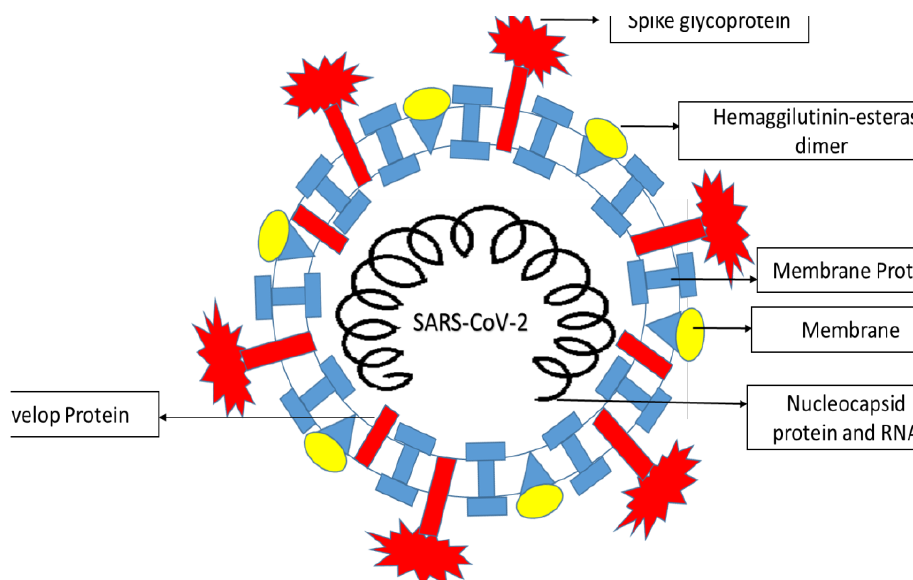
FIGURE 5 -D iagrammatic representation of structure of Coronavirus.